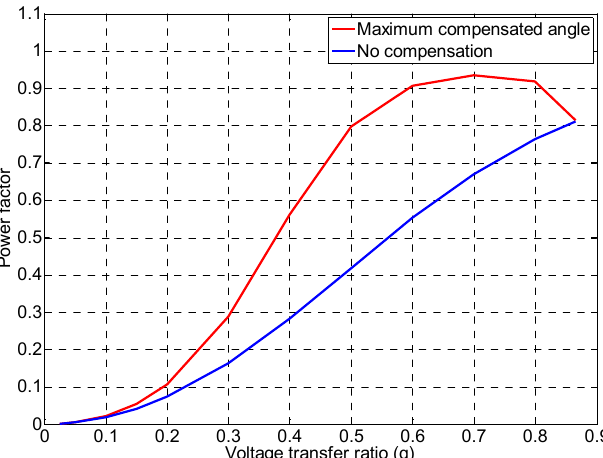
Figure 19. Comparison between IPF under no compensation and maximum compensated angle conditions at Q = 0.54 .